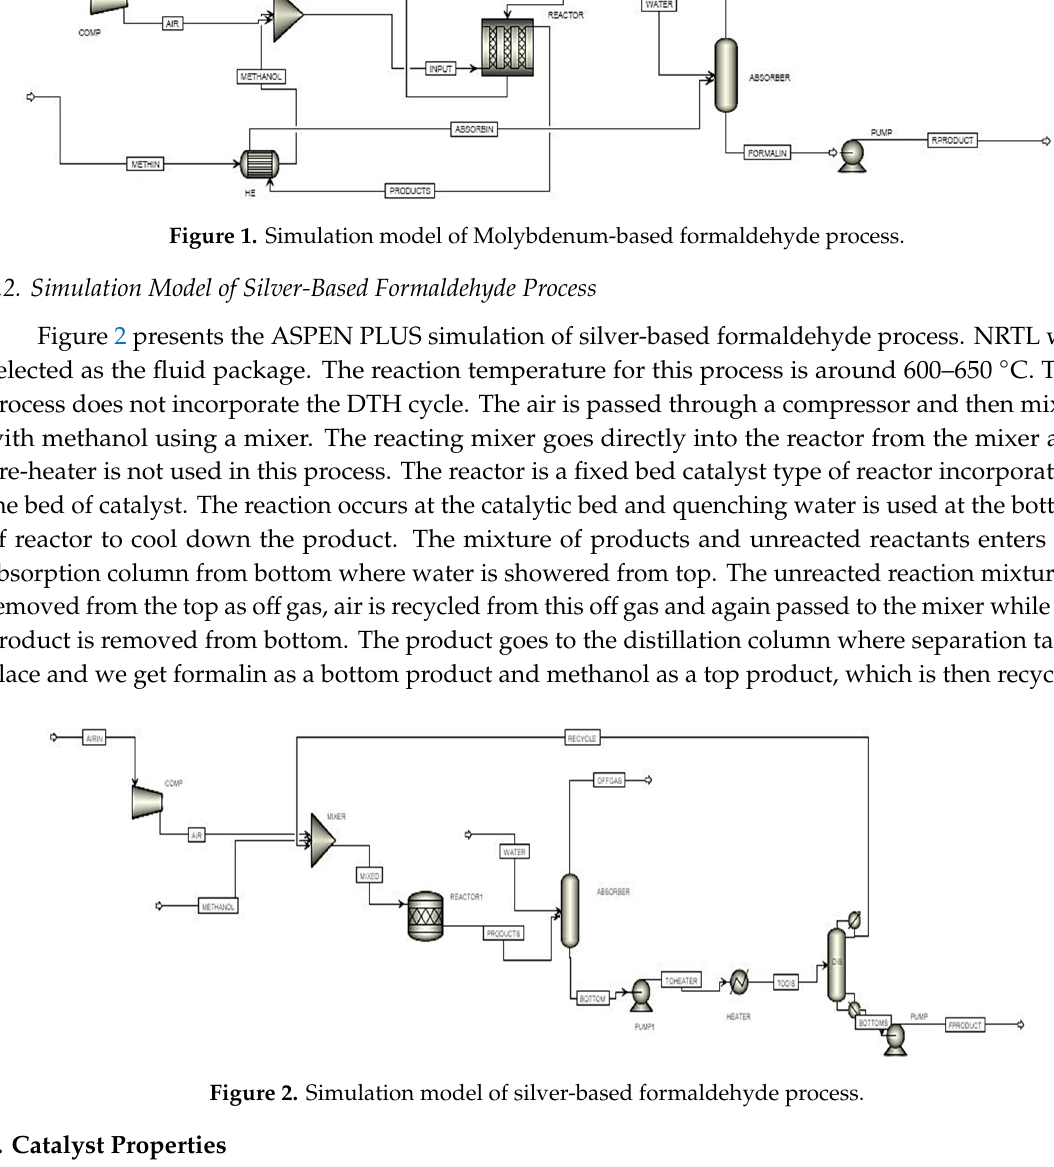
Figure 2. Simulation model of silver-based formaldehyde process.